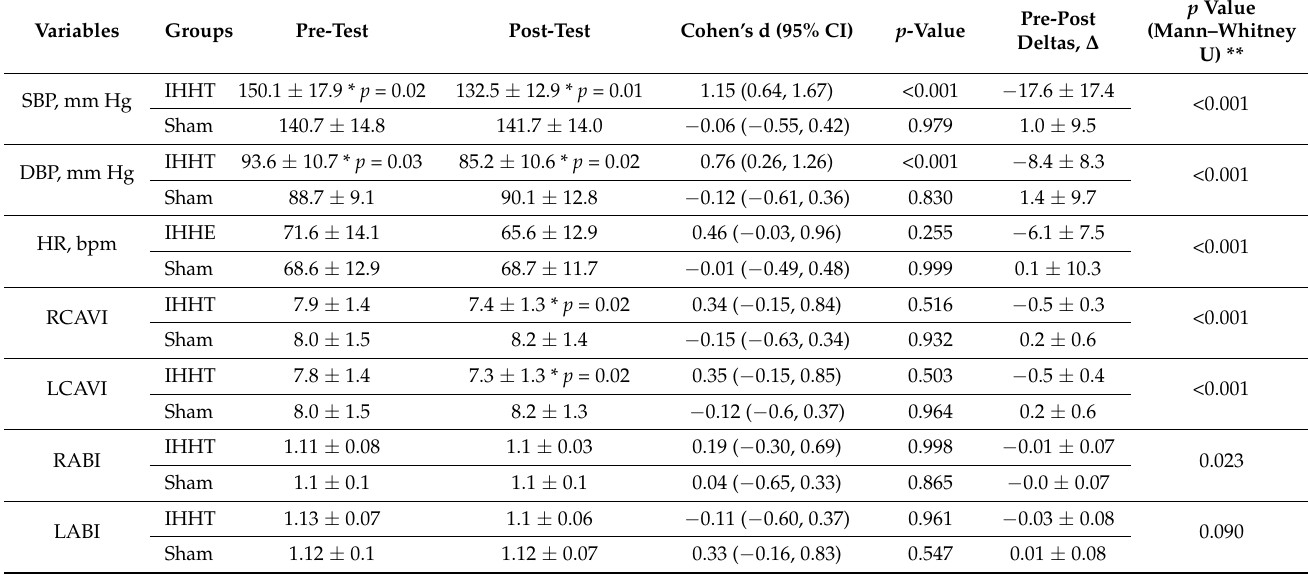
Table 2. Pre- and post-intervention data for hemodynamic parameters with the main analysis of covariance results and